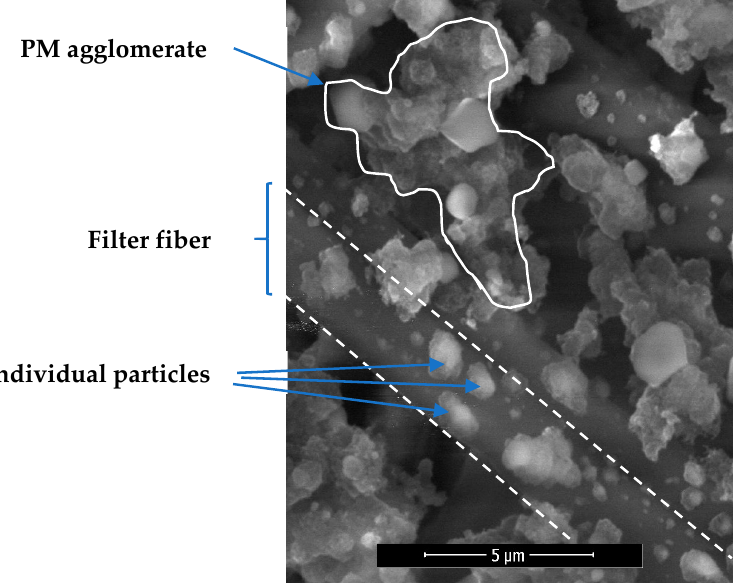
Figure 5. SEM result of PM collected on the filter for Exp 1 at 325 cm (chimney) measurement posi- tion.